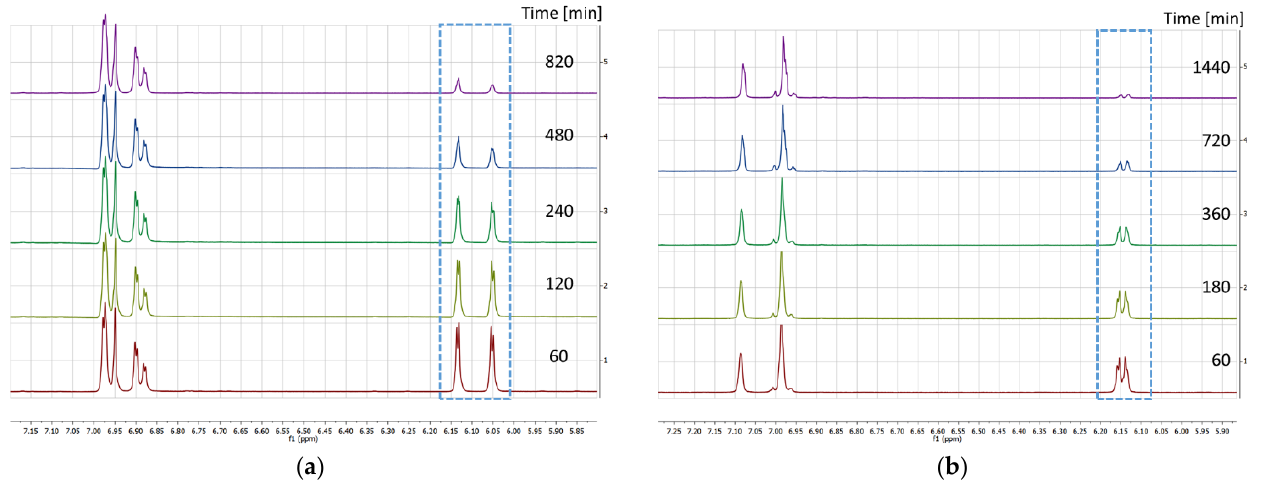
Figure 1. Downfield region of 1 H-NMR spectra of 10 mM solutions of ( a ) 4a and ( b ) 5a in D 2 O taken at different times (T = 310 K).